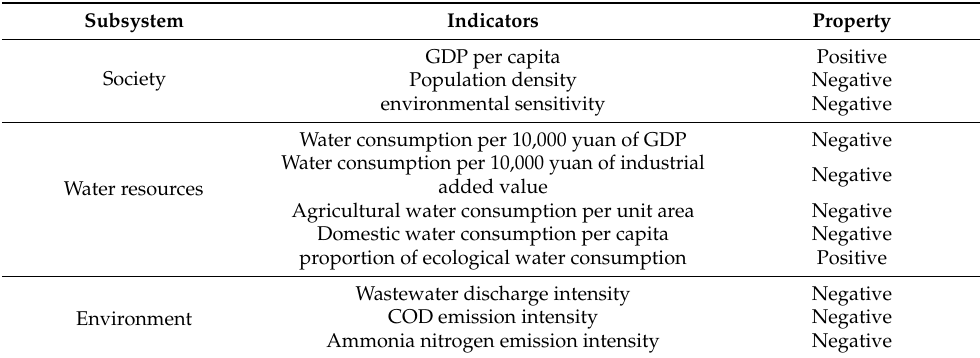
Table 1. The CCD evaluation indicator system of the SWE coupling